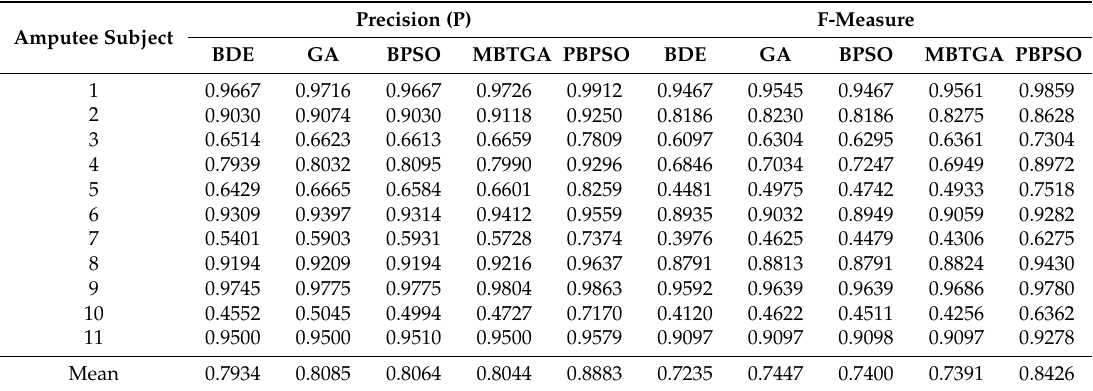
Table 2. Results of precision and F-measure of five different feature selection methods for 11 subjects.